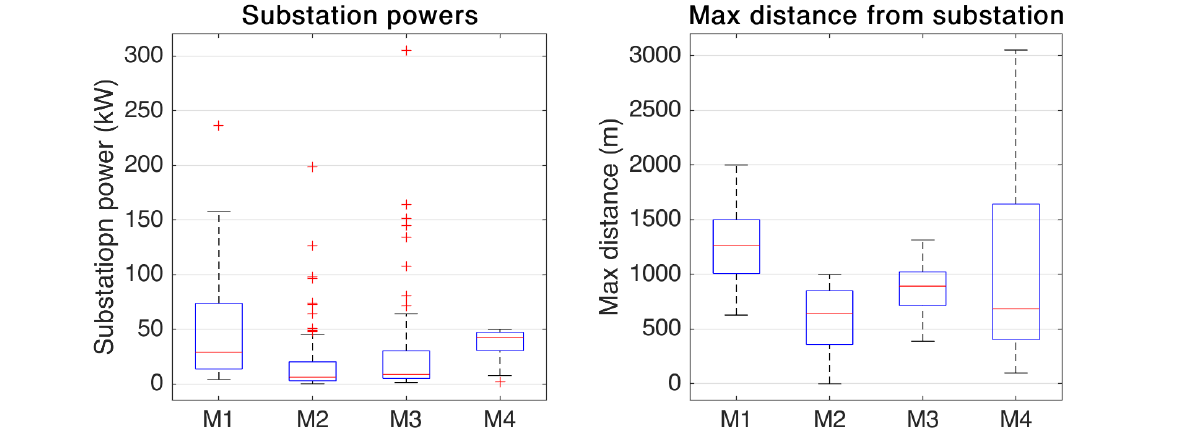
Figure 4. Namanjavira-Power and max distance distribution.